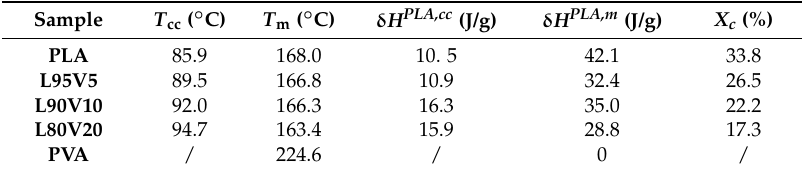
Table 1. Detailed information obtained from DSC thermal analysis of PLA fiber and its